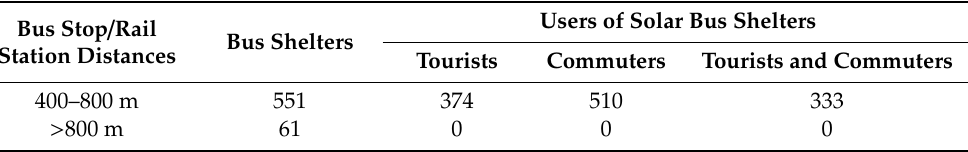
Table 3. Solar bus shelters according to estimated